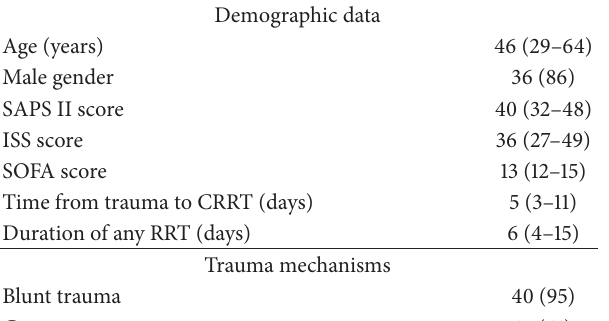
Table 1: Patient characteristics, trauma mechanism, and organ injuries in trauma patients with acute kidney injury treated with continuous renal replacement therapy ( 𝑛 = 42 ).